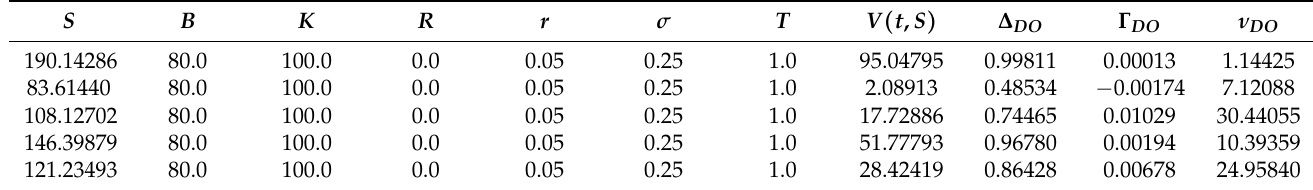
Table 9. Data subset of option values and